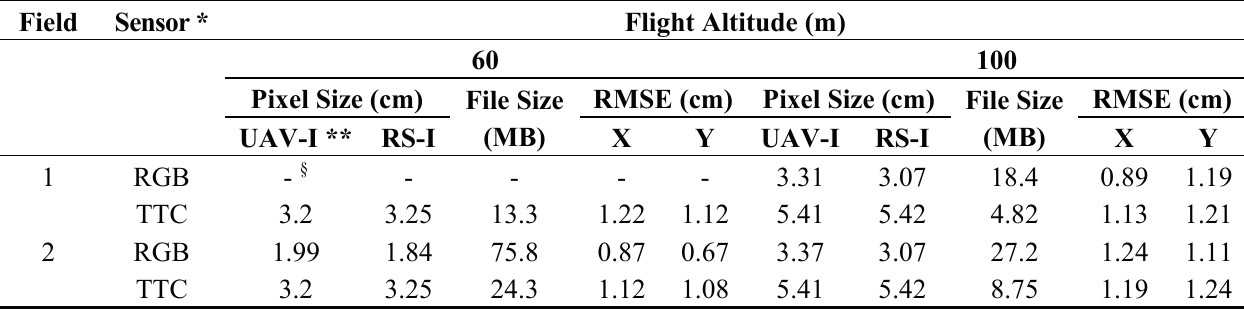
* RGB: Red-Green-Blue (visible range), TTC: Tetracam, Blue-Green-Red-Near Infrared range; ** UAV-I: UAV-imagery, RS-I: Resampled-imagery; § data not available.